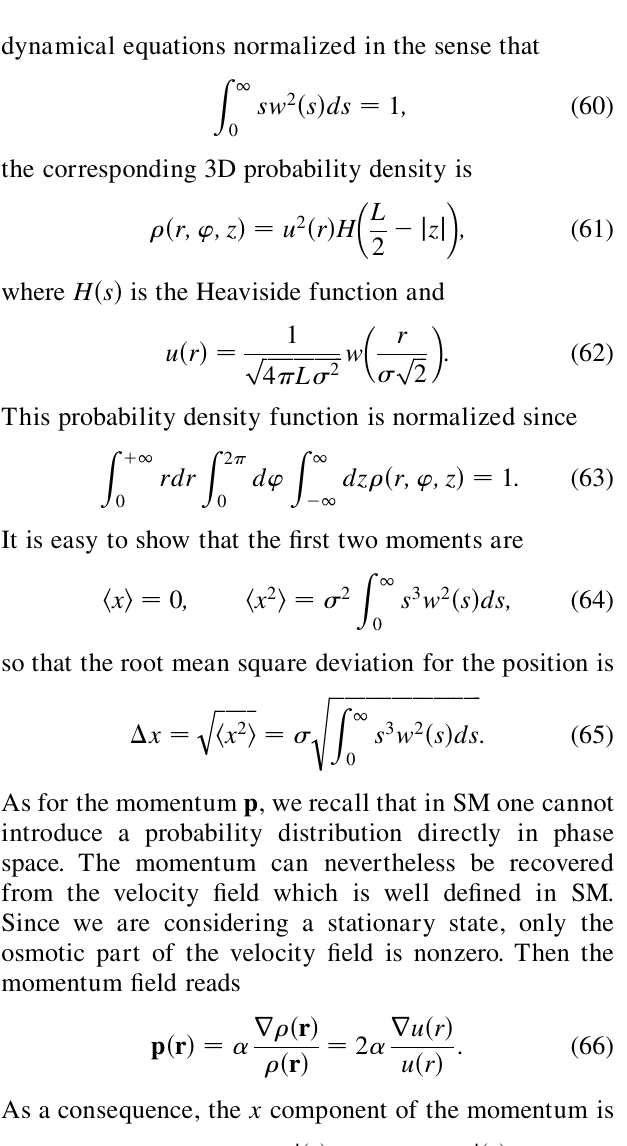
FIG. 6. The total radial potential felt by a particle in the beam compared with the harmonic potential (dashed line) for a space-charge strength of (cid:7) (cid:21) 11 : 2 .